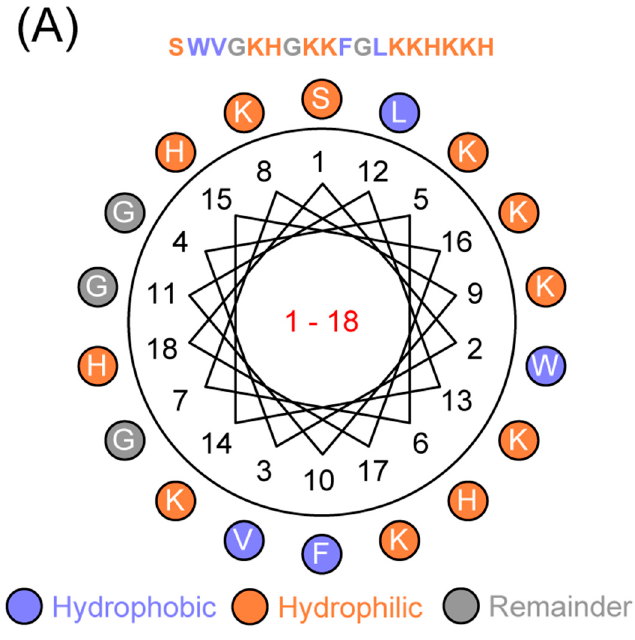
Figure 1. Cont. Figure 1.